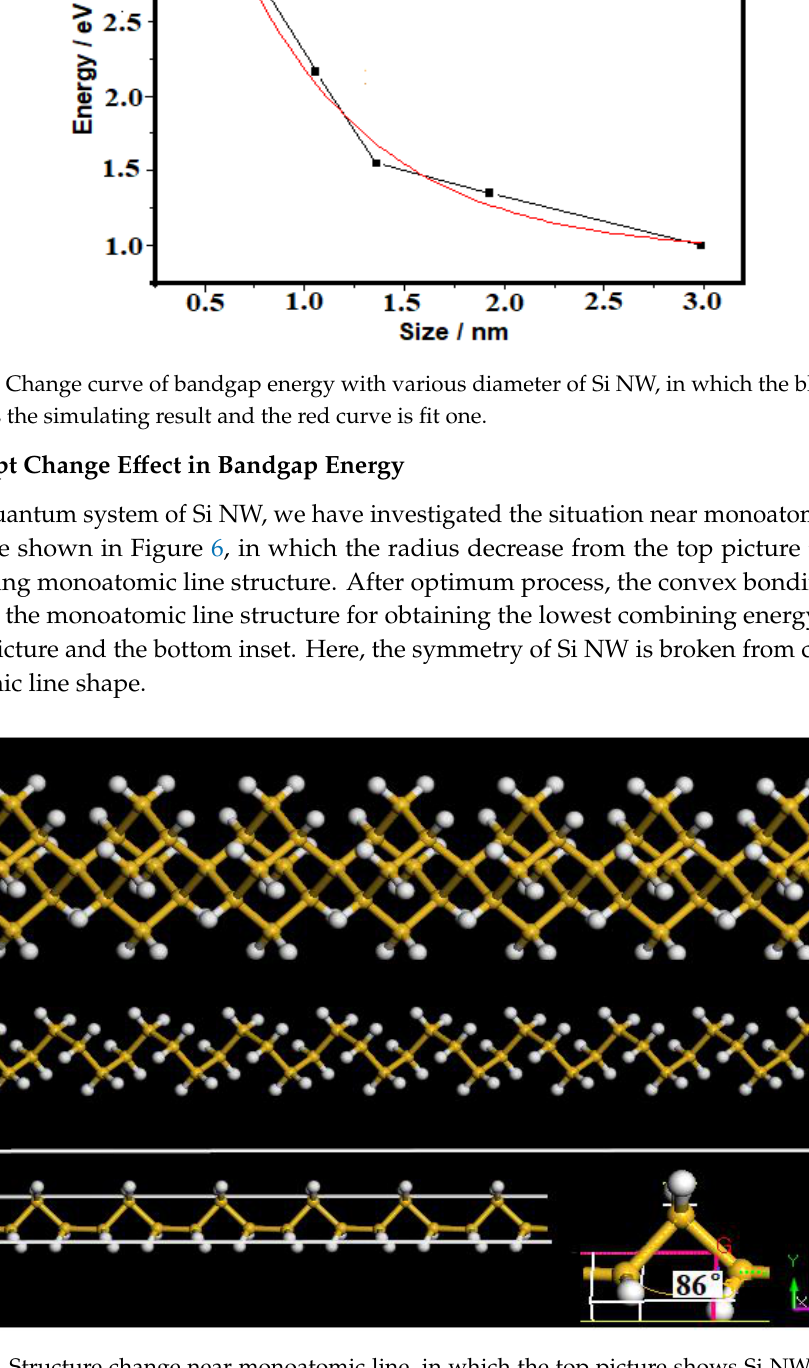
Figure 6. Structure change near monoatomic line, in which the top picture shows Si NW structure with radius of 0.55nm, the mid picture shows Si NW structure with radius of 0.25 nm, and the bottom picture exhibits monoatomic line structure of silicon in which the convex bonding angle with 86° occurs at lowest combining energy as shown in the bottom inset.